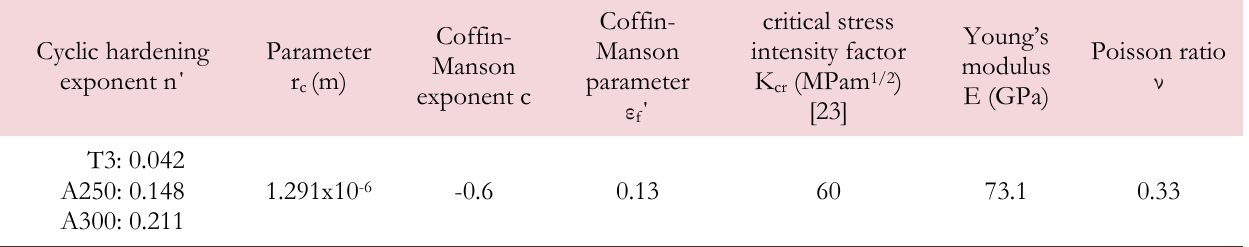
Table 2: Material parameters used in Eq. (7) for FCG